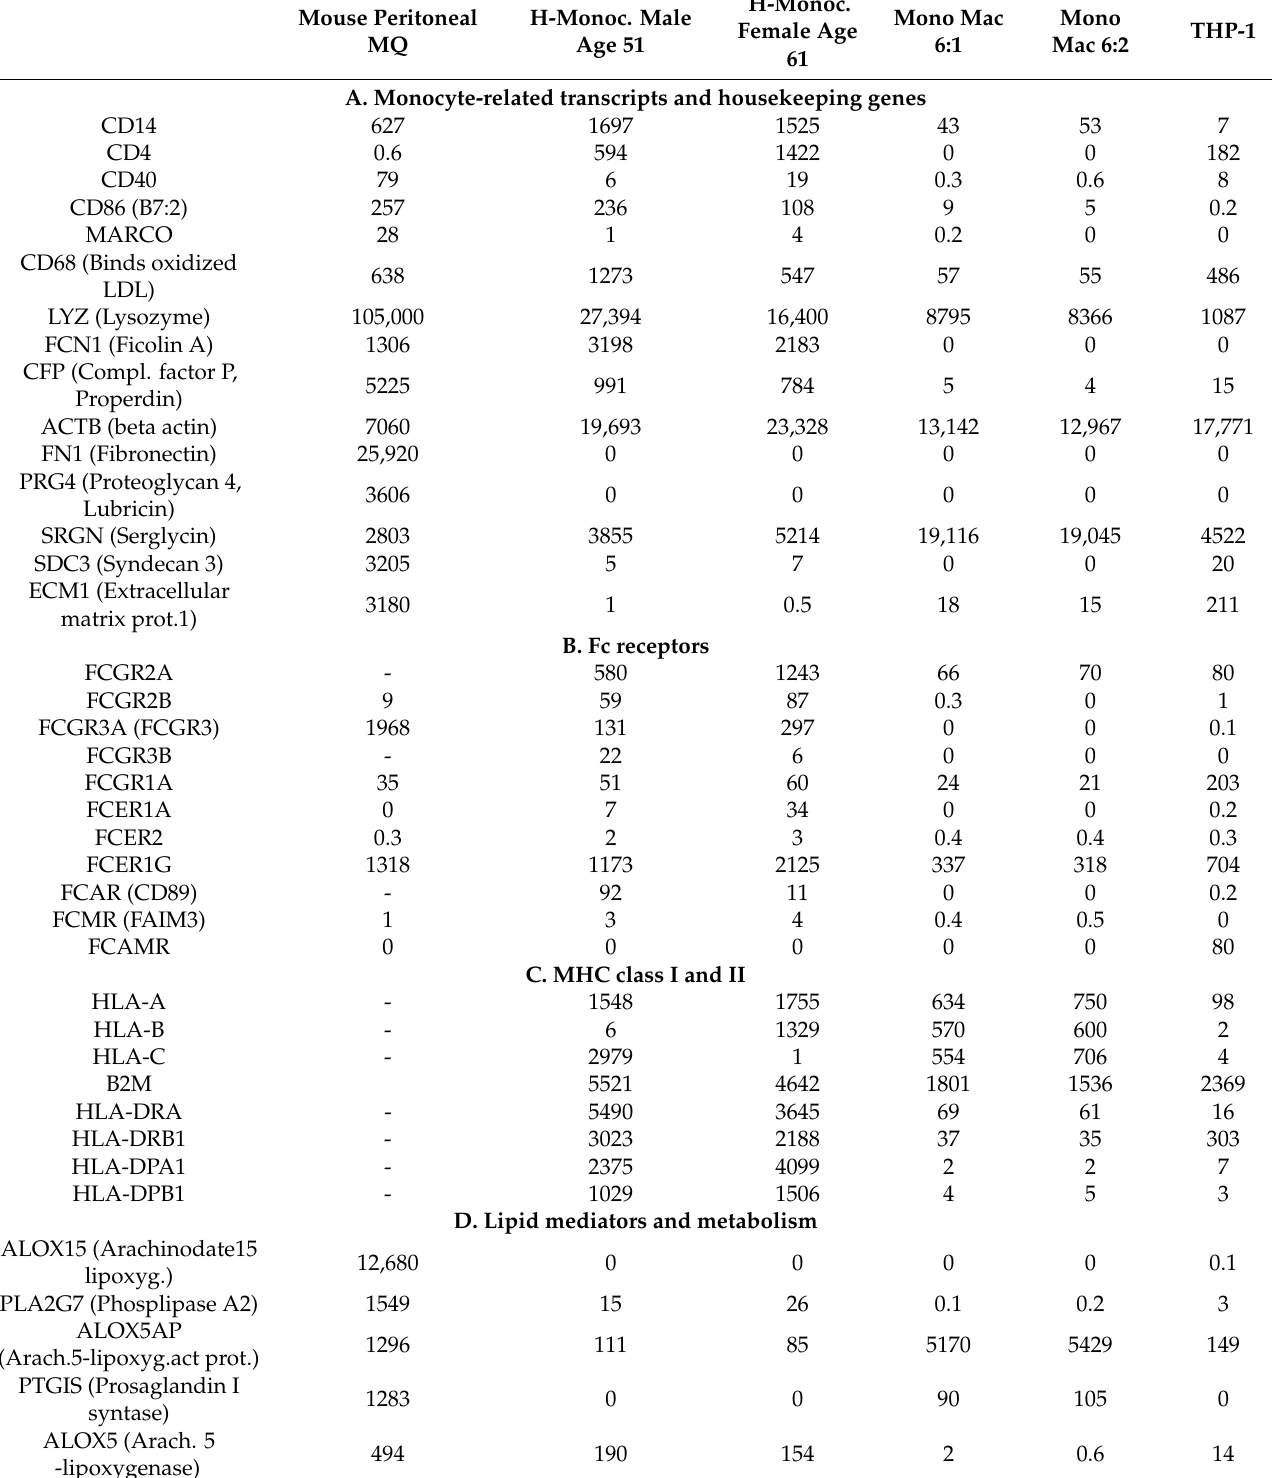
Table 1. Expression levels for a panel of hematopoietic makers genes in mouse peritoneal macrophages, in two different human monocyte preparations (originating from two different donors) and from two human monocytic cell lines, Mono Mac 6 and THP-1. The number of reads corresponds to the expression level of these genes in the various cell